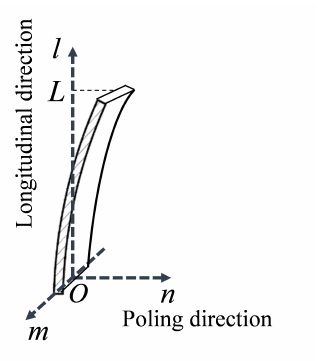
Figure 3. Orientation and geometric deflection of the PVDF polymer film.